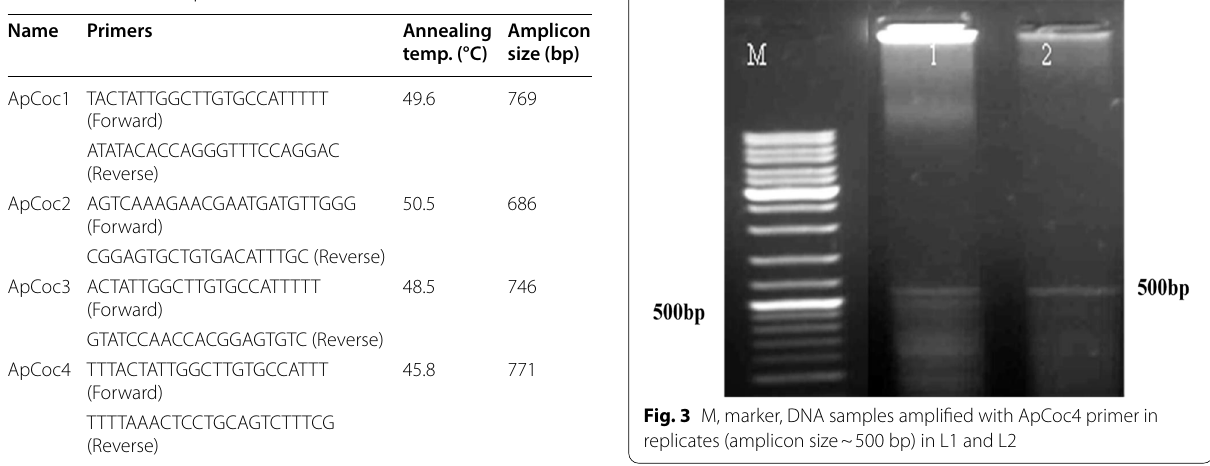
Table 1 Primer sets procured from Xcelris, India Name Primers Annealing